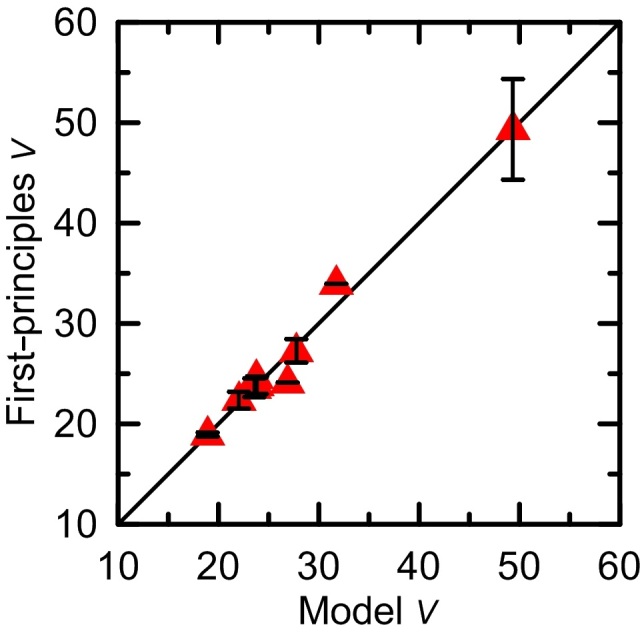
Volume V.Comparison between volume V (in Å3) of many MgO, Al2O3, and SiO2 compounds calculated from DFPT and those derived from optimal Vi values reported for coordination polyhedron i.